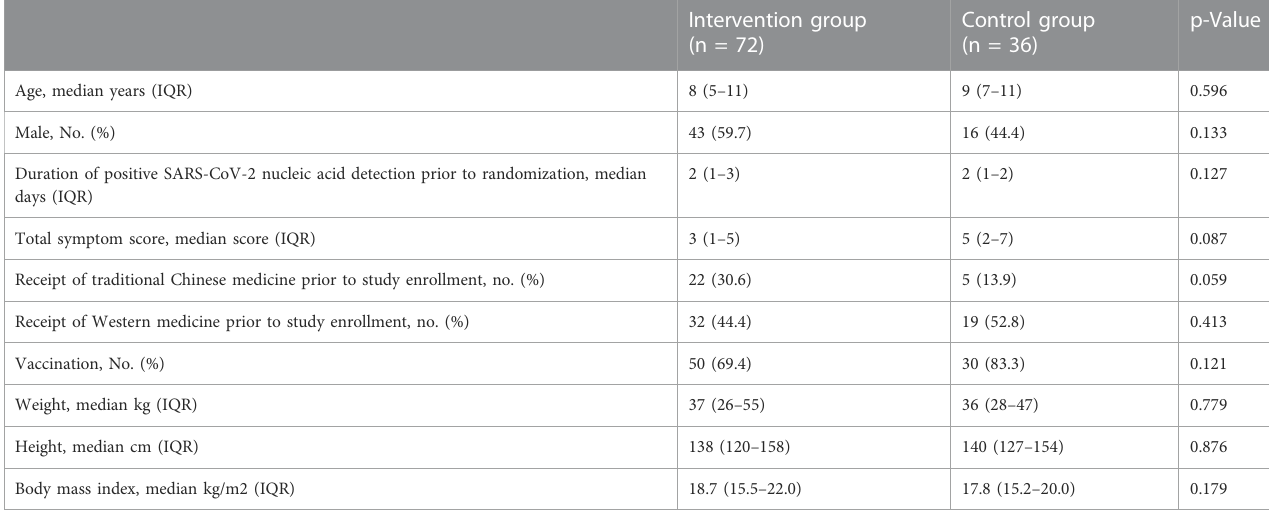
TABLE 1 Characteristics of study participants at